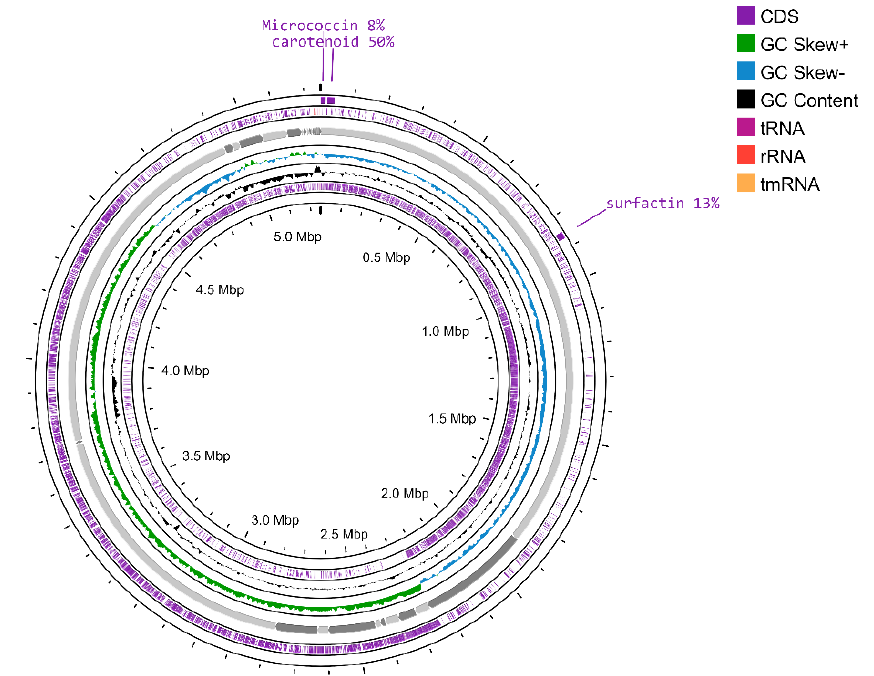
Figure 3. Circular chromosome map of Priestia sp. TSO9, which includes the distribution of CDS, tRNAs, rRNAs, and GC content skew, was created by CGView Server beta.